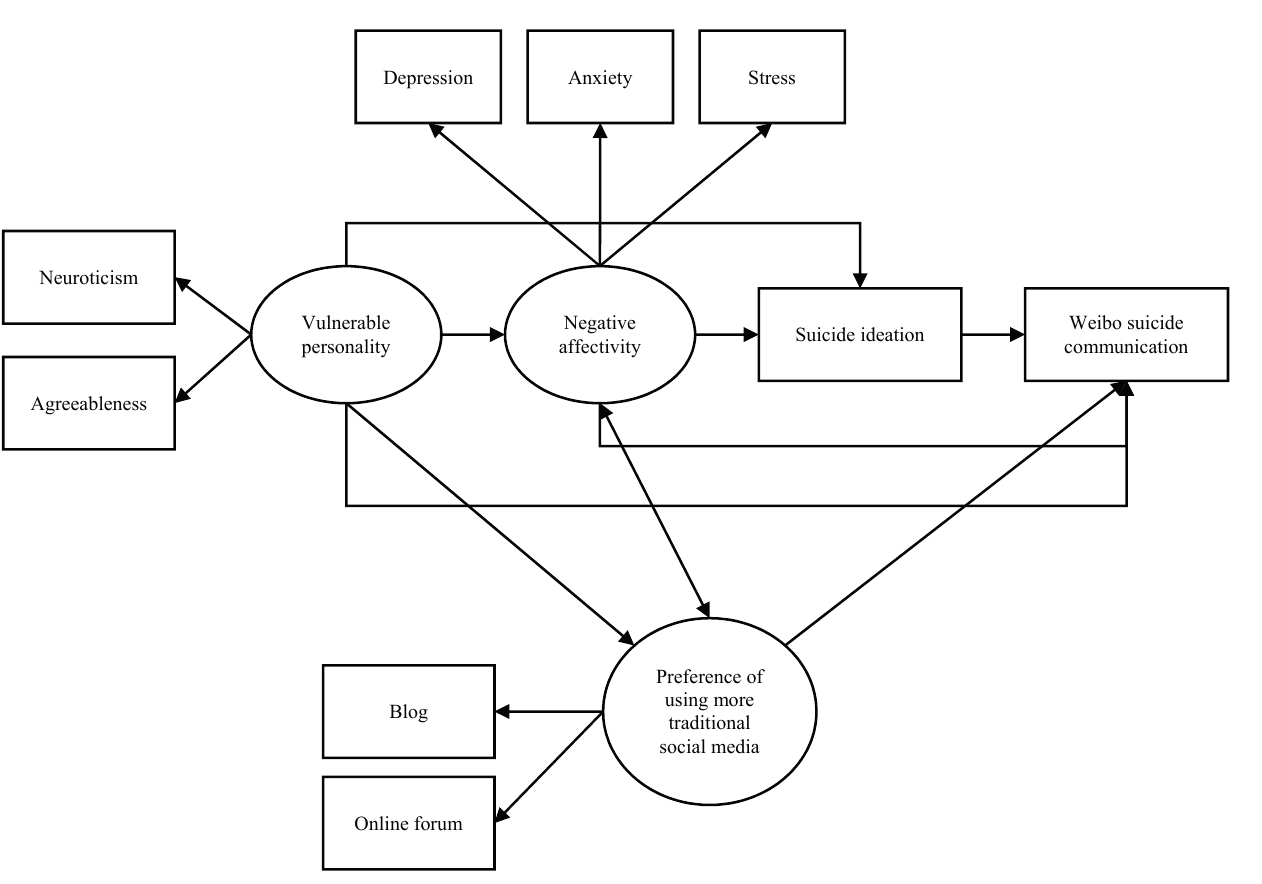
Figure 5. Model 3b, the revision of Model